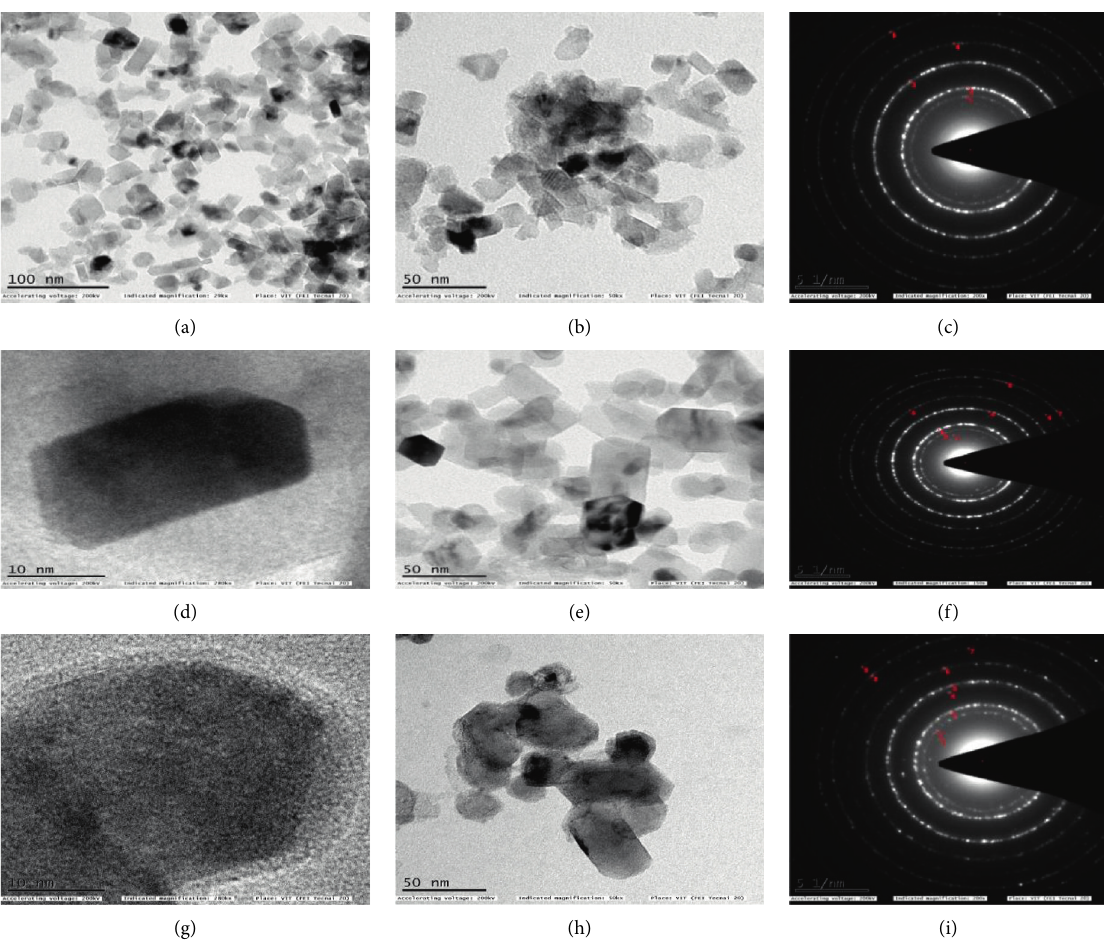
Figure 7: HR-TEM images and SAED patterns of MgO nanoparticles at 500 ° C (a–c), 600 ° C (d–f), and 700 ° C